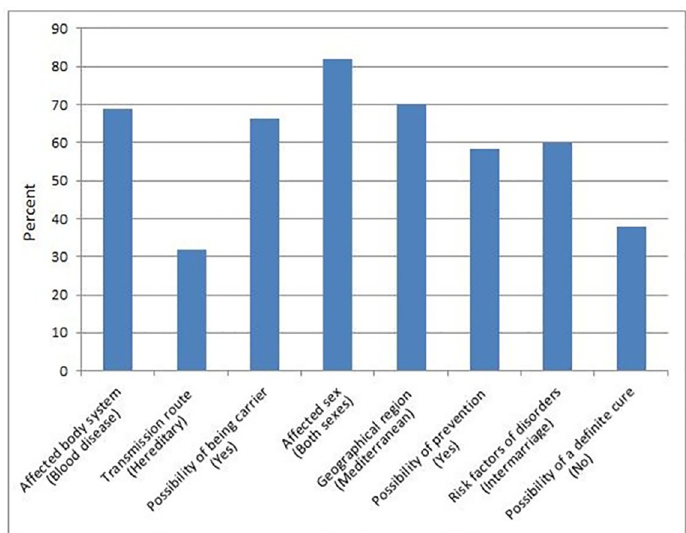
Fig 1. Student ’ s correct answer rates to the questions regarding haemoglobinopathies.